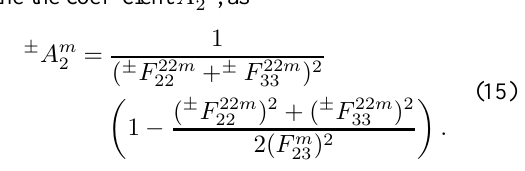
Fig. 3. Display of a one-element model for in-plane shear in